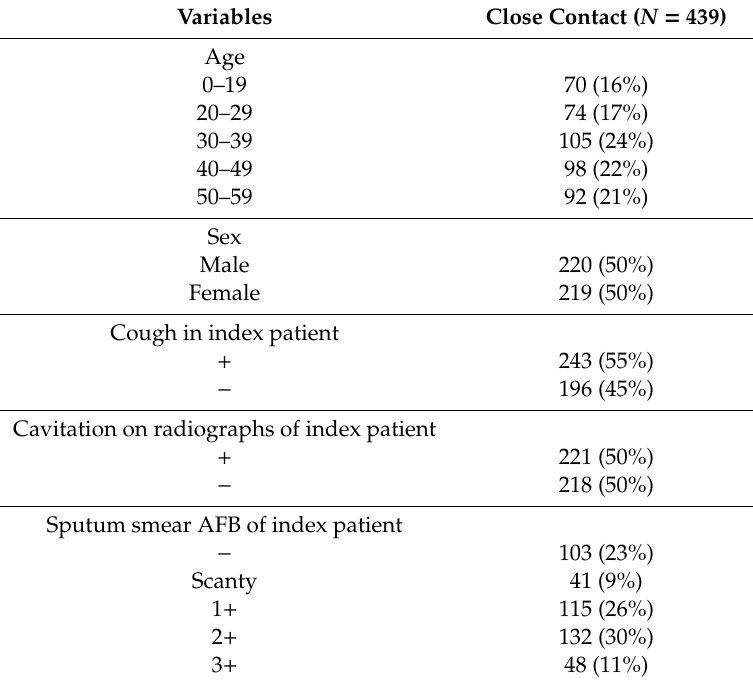
Table 1. Characteristics of close contacts.